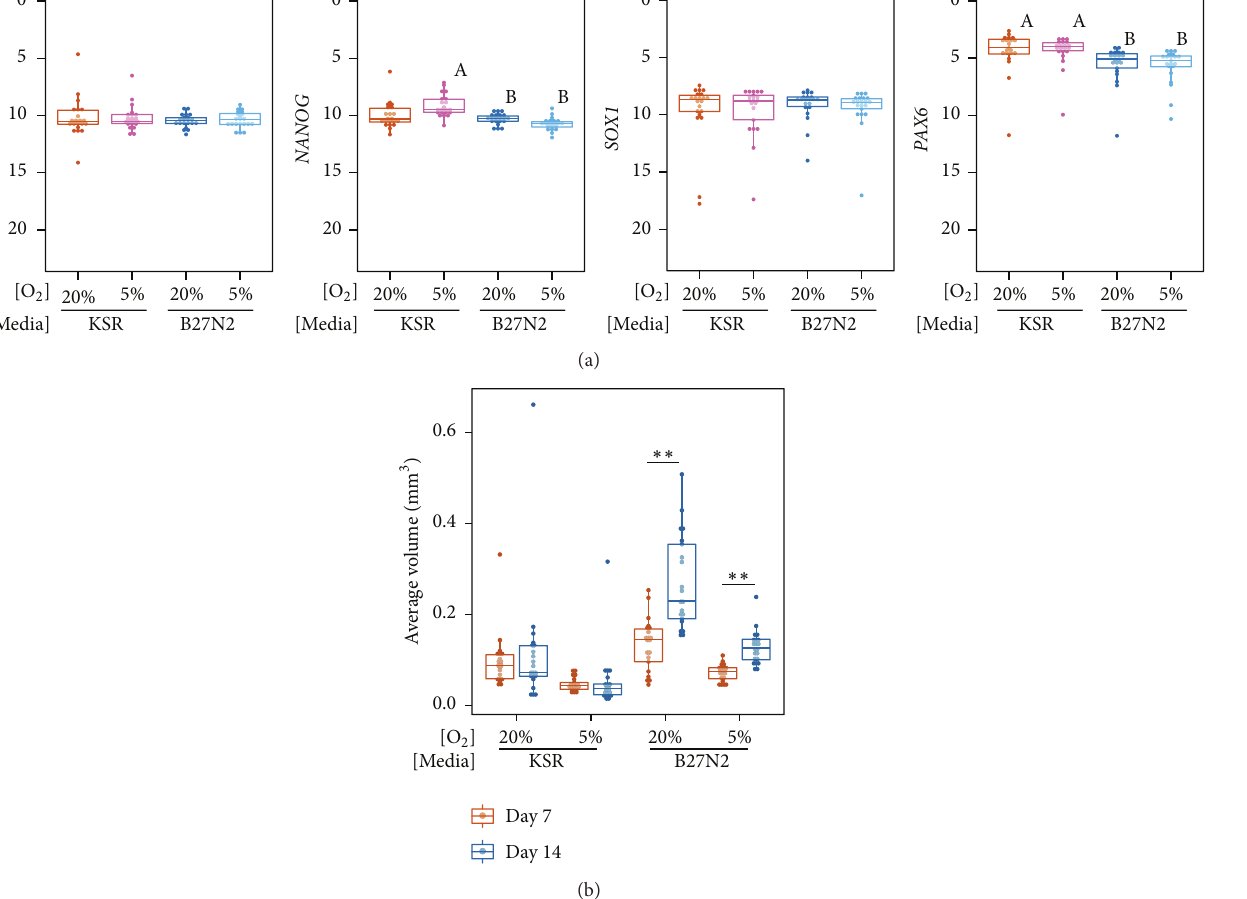
Figure 2: Effects of media and oxygen level on neural aggregate gene expression and size. (a) Dot plots and box plots showing for the gene expression levels of pluripotency markers ( Oct4 and NANOG ) and neural markers ( SOX1 and PAX6 ) in day 14 aggregates cultured in the various conditions. Twenty-one clones were analyzed in each condition. Statistical significance was determined by the Steel-Dwass test. Statistically significant differences ( 𝑝 < 0.01 ) were found between samples “A” and “B”. See also Figure S2. (b) Dot plot and box plot showing the size of day 7 and day 14 neural aggregates. Statistical analysis was performed with the Steel-Dwass test ( ∗∗ 𝑝 < 0.01 ). All 𝑝 values are shown in Table